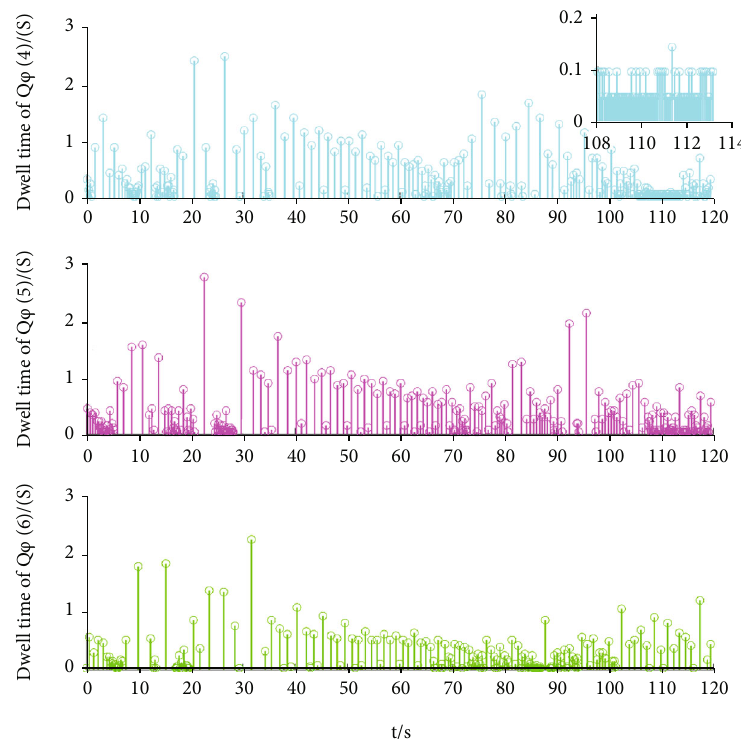
Figure 25: The dwell time of control